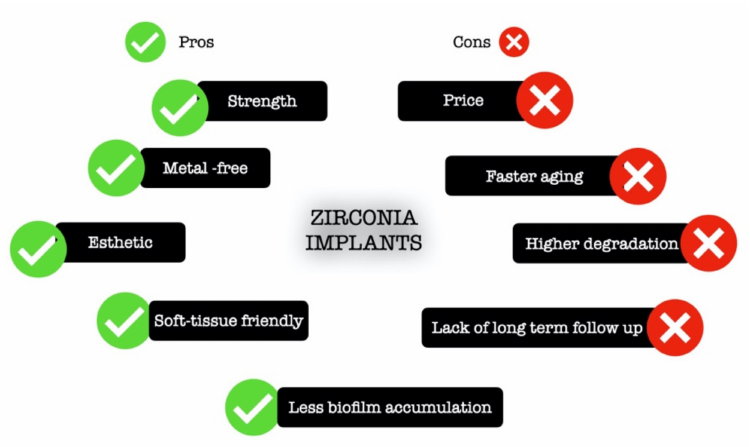
Figure 1. Schematic illustration of the advantages and drawbacks of zirconia